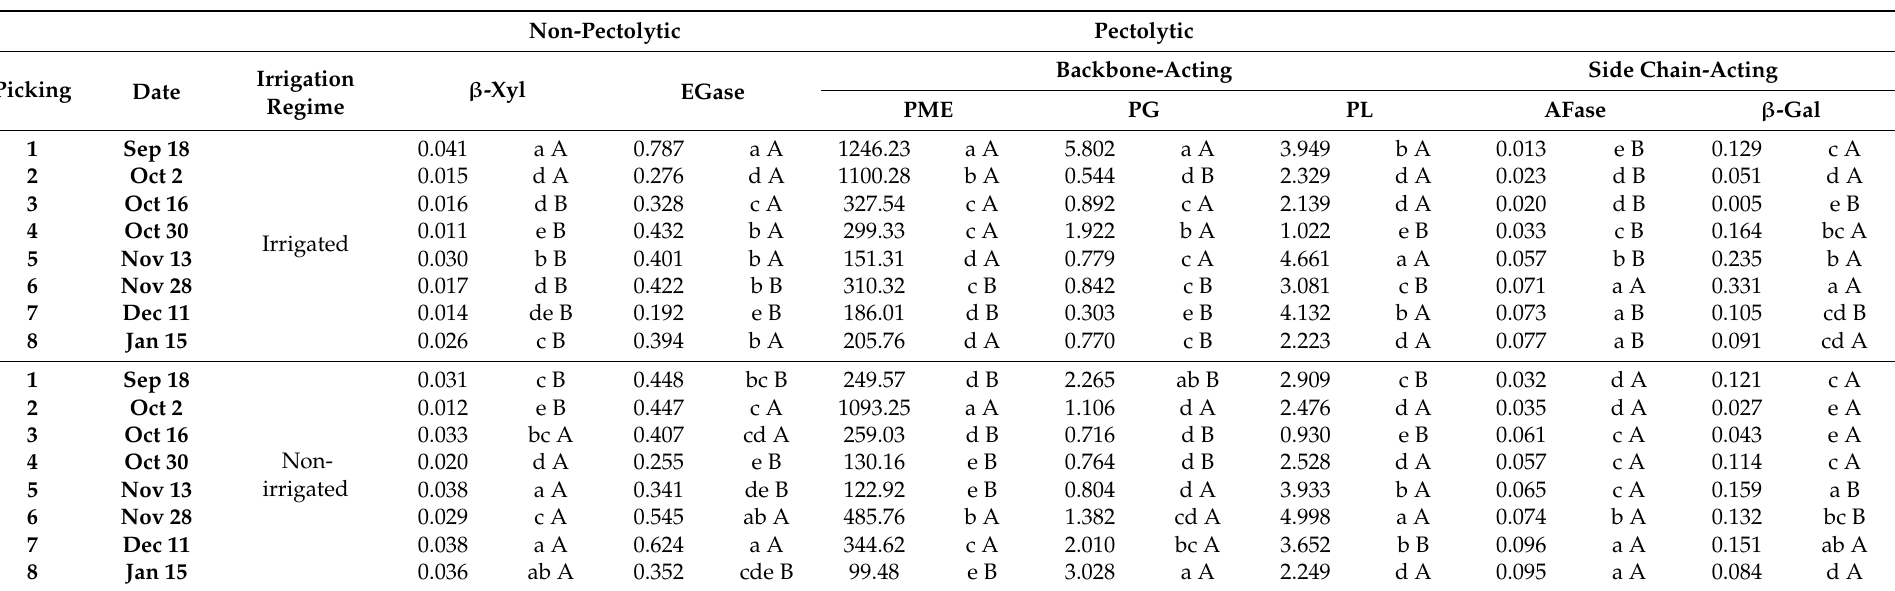
Values represent means of three replicates. Different capital letters denote significant differences between irrigated and rain-fed samples for a given picking date, and different lower-case letters stand for significant differences among sampling dates for a given irrigation regime, at p ≤ 0.05 (LSD test). Abbreviations: β -Xyl, β -xylosidase (EC 3.2.1.37); EGase, endo-1,4- β -D-glucanase (EC 3.2.1.4); PME, pectin methylesterase (EC 3.1.1.11); PG, polygalacturonase (EC 3.2.1.67 -exo- and EC 3.1.2.15 -endo-), PL, pectate lyase (EC 4.2.2.2); AFase, α -L-arabinofuranosidase (EC 3.2.1.55); β -Gal, β -galactosidase (EC